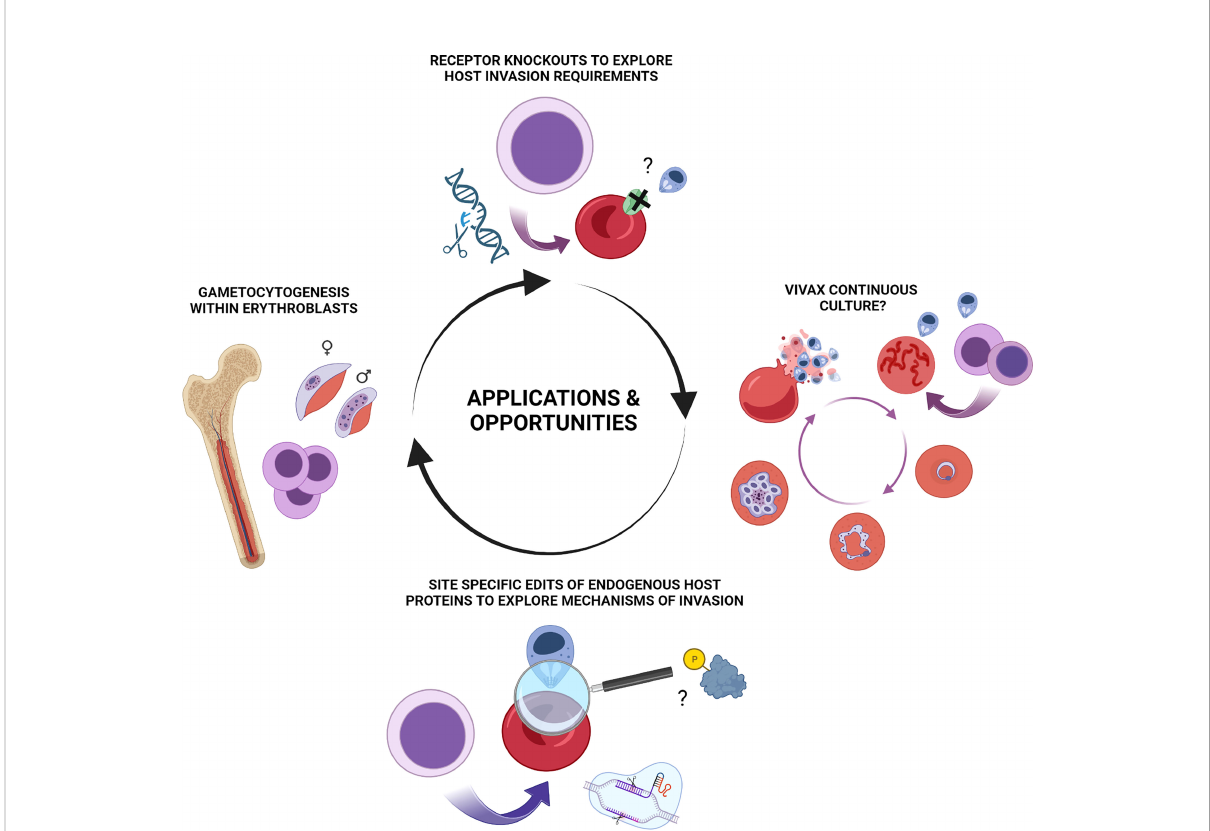
FIGURE 2 Summary of applications and potential opportunities for erythroid stem cell biology to study of malaria pathogenesis. Illustrative summary of applications and opportunities which include generation of novel in vitro derived red blood cell phenotypes for exploration of host protein contribution to invasion, host cell remodelling and other aspects of pathogenesis of blood stage Plasmodium falciparum and Plasmodium vivax infection. CRISPR-mediated NHEJ mediated knock outs, lentiviral rescue experiments and HDR mediated site-speci fi c editing of endogenous loci are each applicable to in vitro erythroid cultures. Emerging and future opportunities include exploration of nucleated erythroblasts as a preferential host environment for gametocytogenesis and the long-standing enigma and quest for a means of continuous ex vivo propagation of Plasmodium vivax. Figure created with